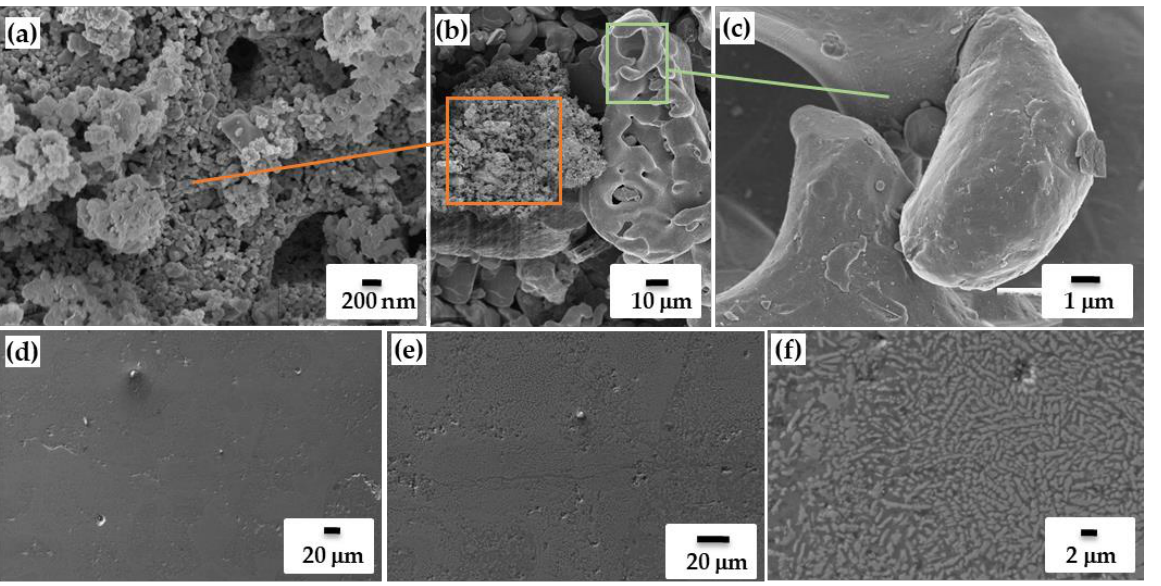
Figure 4. SEM image of TiB 2 -Si powder ( a – c ) and sintered fracture ( d – f adopted from [39]).